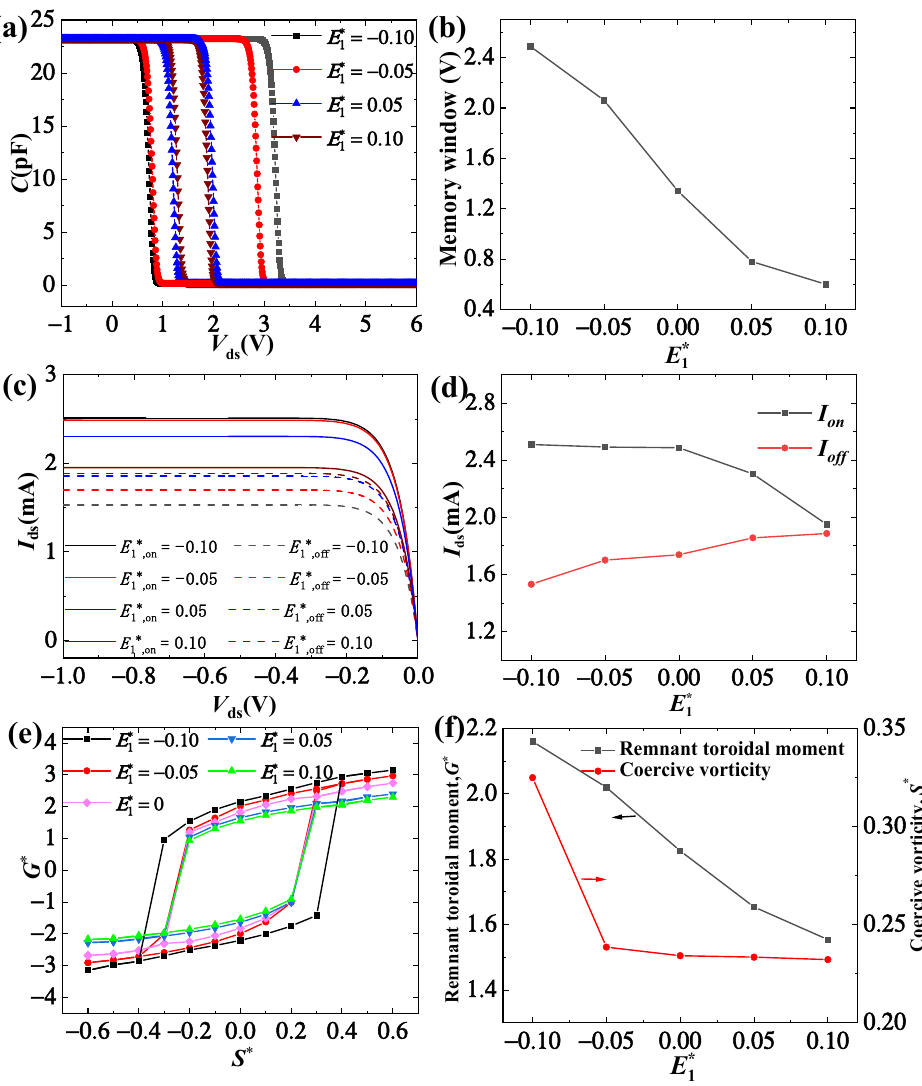
Figure 2. Effect of E * on the ferroelectric topology domain transistors of ( a ) C - V ds characteristics of Pt/PTO (20 nm)/Si/SiO 2 structures. ( b ) Memory window. ( c ) I ds - V ds characteristics of Pt/PTO (20 nm)/Si/SiO 2 structures. ( d ) Open-state current and closed-state current. ( e ) G * - S * . ( f ) Coercive vorticity and remnant toroidal moment. The superscript * indicates the corresponding dimensionless posterior parameter.